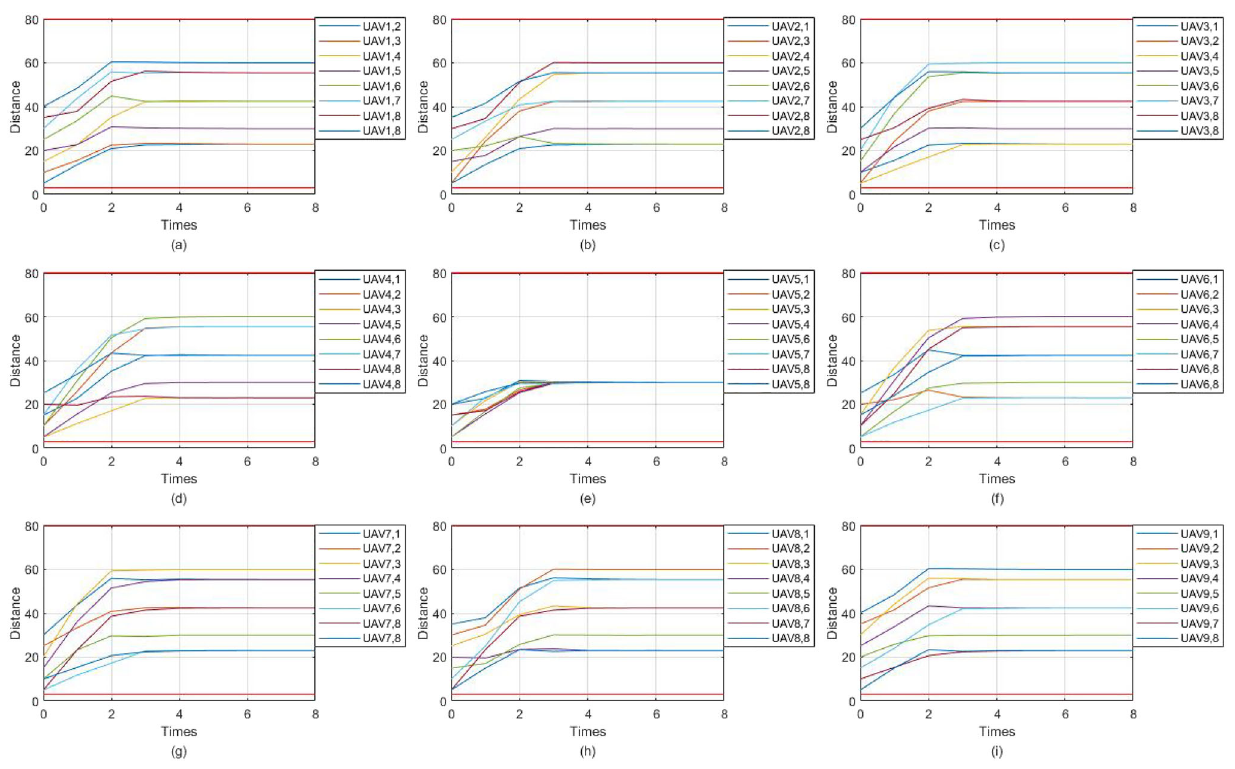
Fig. 17 Distance curve between each UAV for UAV 1–9 ( a )–( i )